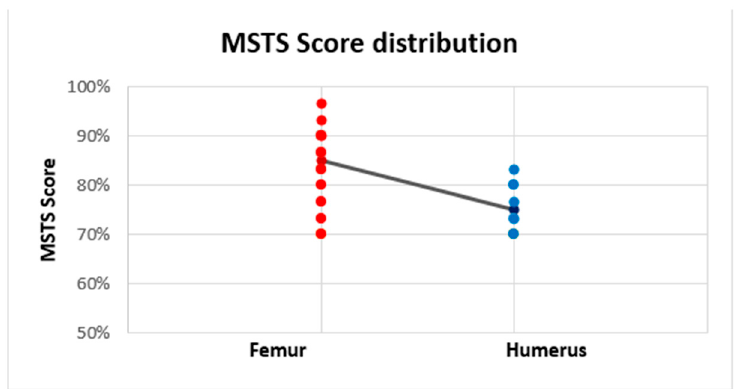
Figure 5. Linear trendline of the Musculoskeletal Tumor Society (MSTS) scores of intercalary endo- prostheses for metastases in the diaphysis of femur and humerus. The MSTS score was higher in the femur (84.8%) than in the humerus (75.9%).